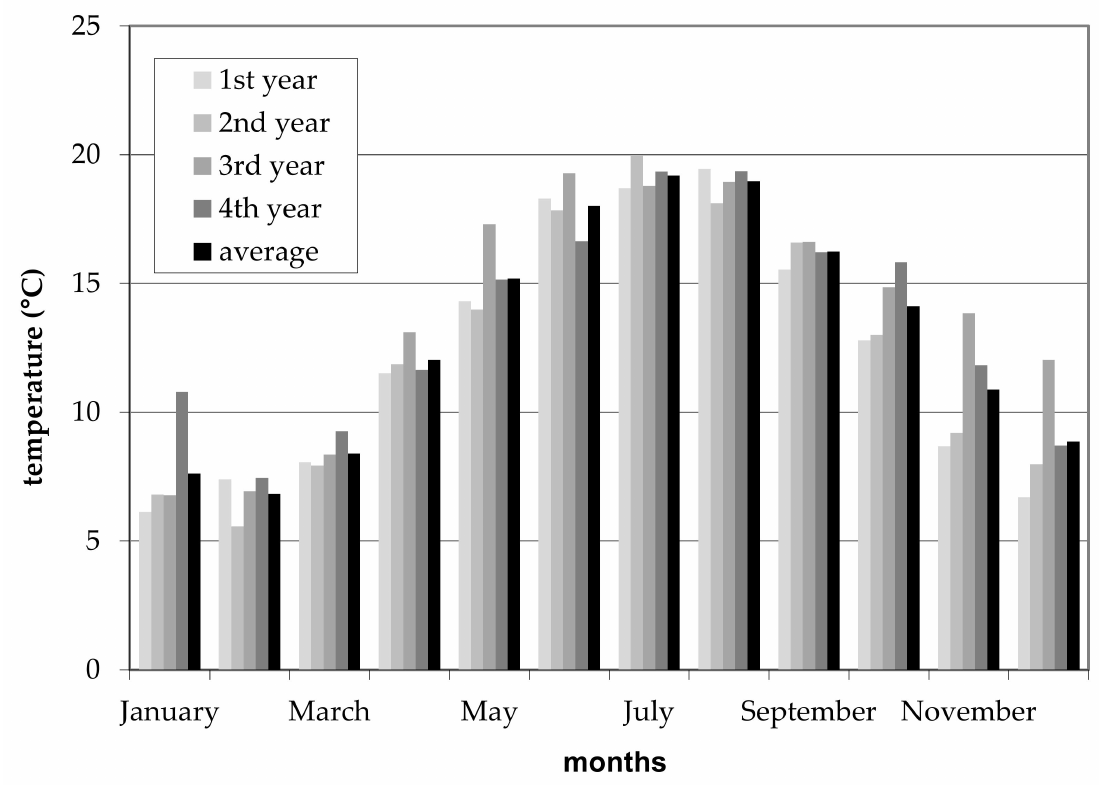
Figure 3. Monthly averages water temperatures in four consecutive years at the station plant and averages of these